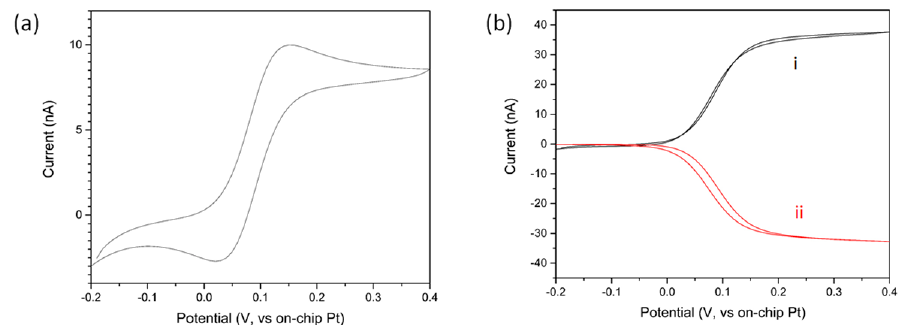
Figure 4. ( a ) Typical cyclic voltammogram in 1 mM FCA in 10 mM PBS measured at a platinum interdigitated electrode comb; ( b ) CVs at the generator and collector IDAs. The generator IDA (i) was cycled between − 0.2 V and 0.4 V while the collector IDA (ii) was held at − 0.1 V.